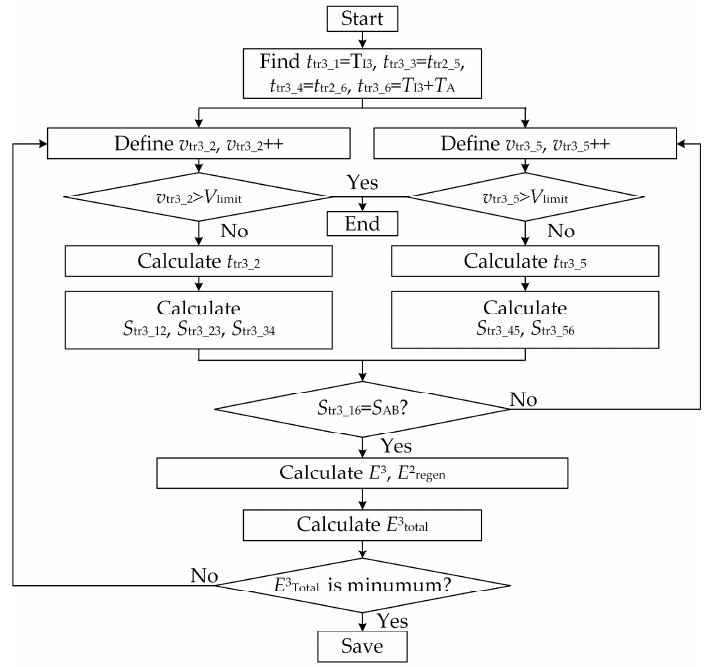
Figure 11. The calculation process of the 3rd train under five-mode operation.